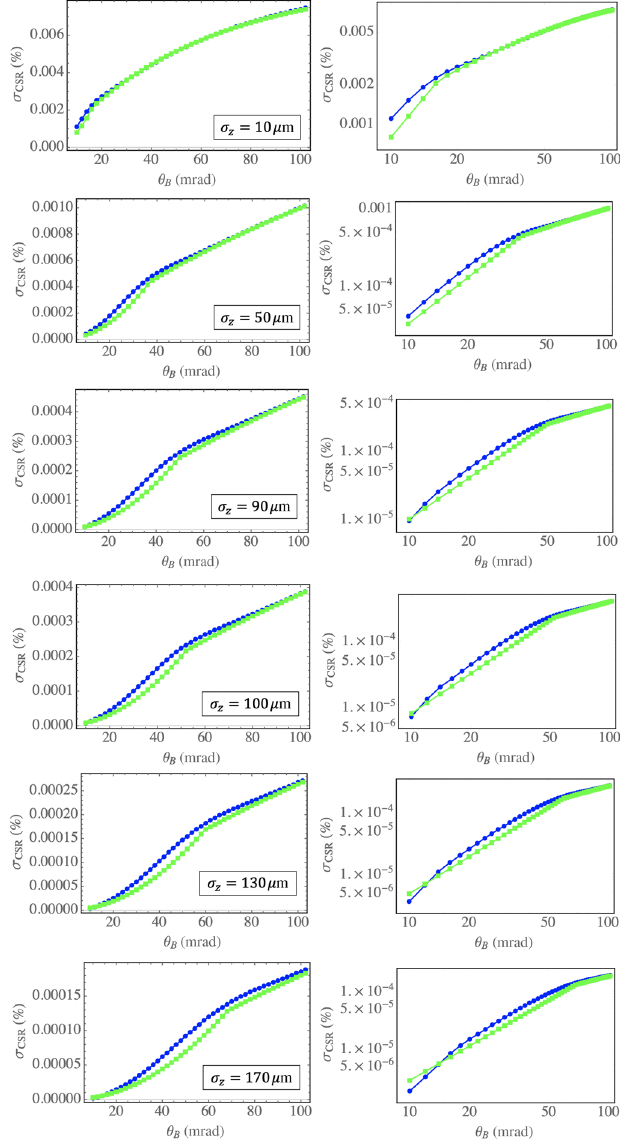
FIG. 3. The CSR rms energy spread versus bend angle of an electron beam traversing a bend ( L B ¼ 0 . 55 m) for various initial bunch lengths. Left column: The CSR rms energy spread from ELEGANT (blue) and Eq. (13) (green). Right: Log-Log plot of the CSR rms energy spread.